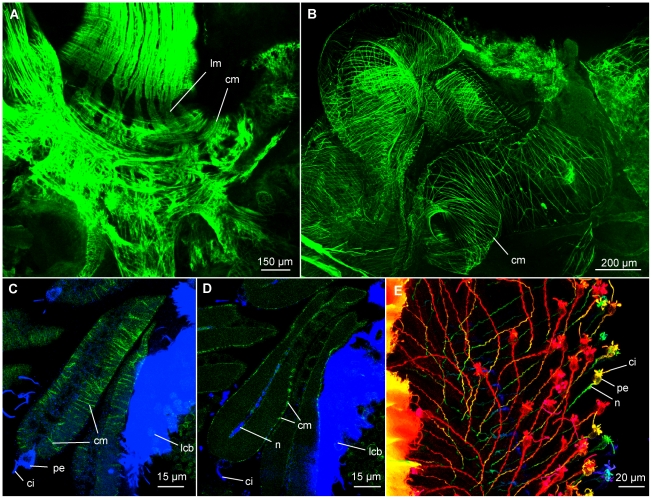
CLSM of the root system and pinnules of Osedax mucofloris females.A: Single z-stack image of the ‘trunk-root system’ connection, note the bundles of longitudinal muscles. B: Musculature located by the ovisac, assumed to be the posterior end of the longitudinal dorsal blood vessel. C: Single z-stack image of pinnules, circular musculature encircling the pinnular loop, note the distal perikaryon and sensory cilia. D: Single z-stack image showing a longitudinal section of the pinnule in C, note the internal nerve. E: Depth coded z-stack, pinnule nerves in Osedax ‘yellow-collar’. Abbreviations: cilia (ci), circular muscles (cm), lateral ciliary band (lcb), longitudinal muscles (lm), nerve (n), perikaryon (pe).